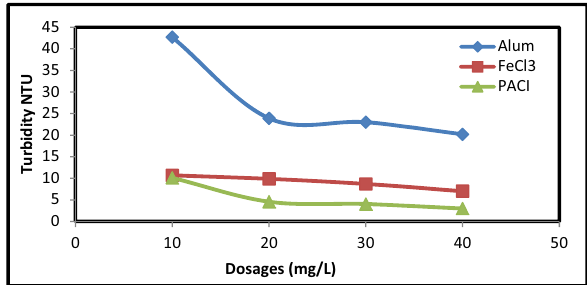
Figure 13: The relationship between coagulants and fi nal residual turbidity for samples at a height of 60 cm.